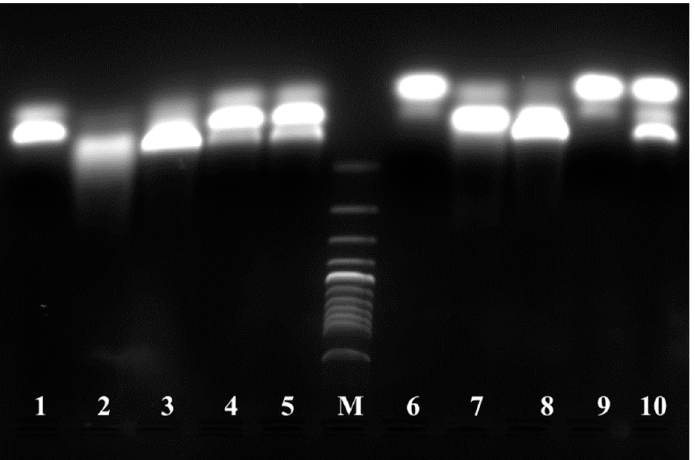
Figure 8. Electrophoretic shift assay with a 27-bp arsR promoter DNA fragments with ArsR proteins. FAM-labeled DNA fragments were incubated with or without purified ArsR proteins for 30 min at room temperature. The mixtures were electrophoresed on 3% agarose gels at 7 °C with ethidium bromide and visualized by UV-transilluminator. When either 10 μ M PDNA1 (lane 1) or PDNA2 (lane 6) was incubated with the recombinant protein 10 μ M ArsR1 (lane 2 and 3) or ArsR2 (lane 7 and 8), retardation due to DNA-protein complex formation was observed. The retardation was almost suppressed in the presence of 1 mM sodium arsenite (lanes 4 and 9) or 1 mM diamide (lanes 5 and 10) for both complexes. M means the marker and it was 100 bp DNA ladder from Promega.